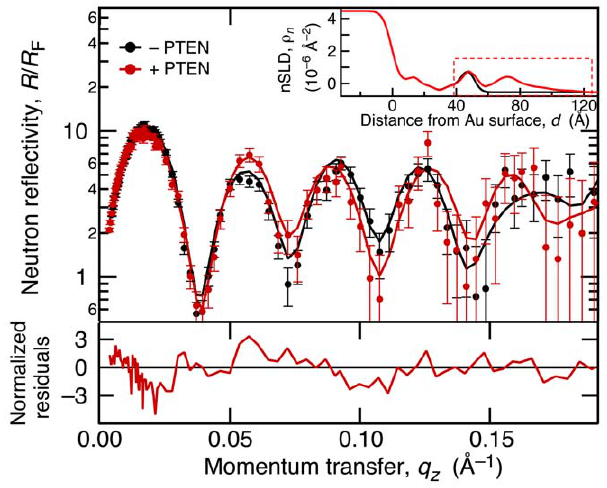
Figure 2. Quantification of PTEN Binding to stBLMs by Neutron Reflection. Exemplary NR data set showing the changes of the neutron reflection upon wt PTEN association with a preformed stBLM composed of DOPC:DOPS 70:30, the residuals which emphasize these changes (bottom), and the corresponding nSLD profiles (inset). The NR spectra (main panel) for the stBLM before (black) and after incubation with 20 m M wt PTEN (red) are normalized to the Fresnel reflectivity— i.e. , the reflectivity of a neat Si/buffer interface without interfacial roughness—in order to emphasize the interference patterns due to the interfacial structures. Changes of the spectra upon PTEN association with the membrane are shown as residuals, normalized to the magnitude of the experimental errors, at the bottom. Lines in the main panel show the computed NR of the nSLD profiles shown in the inset. Note that these profiles are derived by fitting multiple data sets simultaneously (neat stBLM and stBLM with PTEN, each measured at different isotopic buffer contrasts) by sharing model parameters as appropriate. A dashed box in the inset indicates the region of the distal lipid headgroups and associated PTEN protein, shown in close-up view in Fig. 4. The signal-to-noise in these measurements is comparable to that in similar studies on the incorporation of a -hemolysin into stBLMs [33] and the binding of the HIV-1 matrix protein to bilayer surfaces [34].